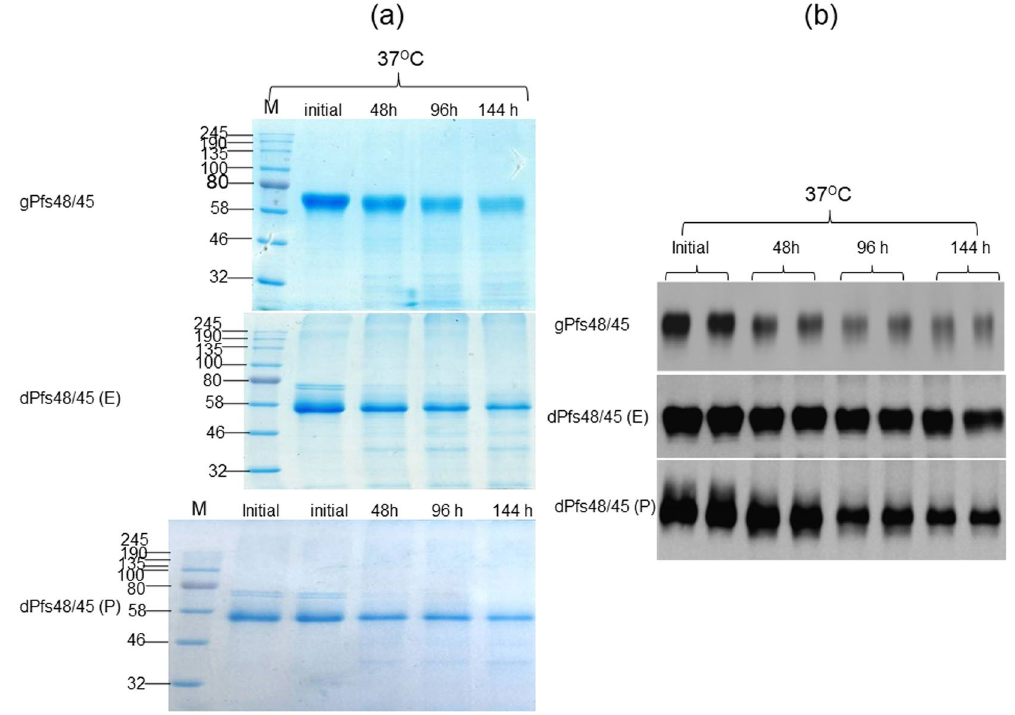
Figure 3. Stability of glycosylated and deglycosylated Pfs48/45 variants. Plant produced, FLAG antibody affinity column purified glycosylated Pfs48/45 (gPfs48/45) and in vivo Endo H (dPfs48/45 (E)) or PNGase F (dPfs48/45 (P)) deglycosylated variants of Pfs48/45 were incubated at 37 °C for 48, 96 and 144 hours, and analyzed in SDS-PAGE ( a ) or western blot ( b ). Lanes were loaded with ~2.0 μ g per lane of Pfs48/45 proteins. M: color prestained protein standard. ( b ) Hundred ng per lane of Pfs48/45 proteins were run in SDS-PAGE prior to western blotting. Proteins on the blot were probed with anti-FLAG antibody. The image was taken using the highly sensitive GeneGnome XRQ Chemiluminescence imaging system.